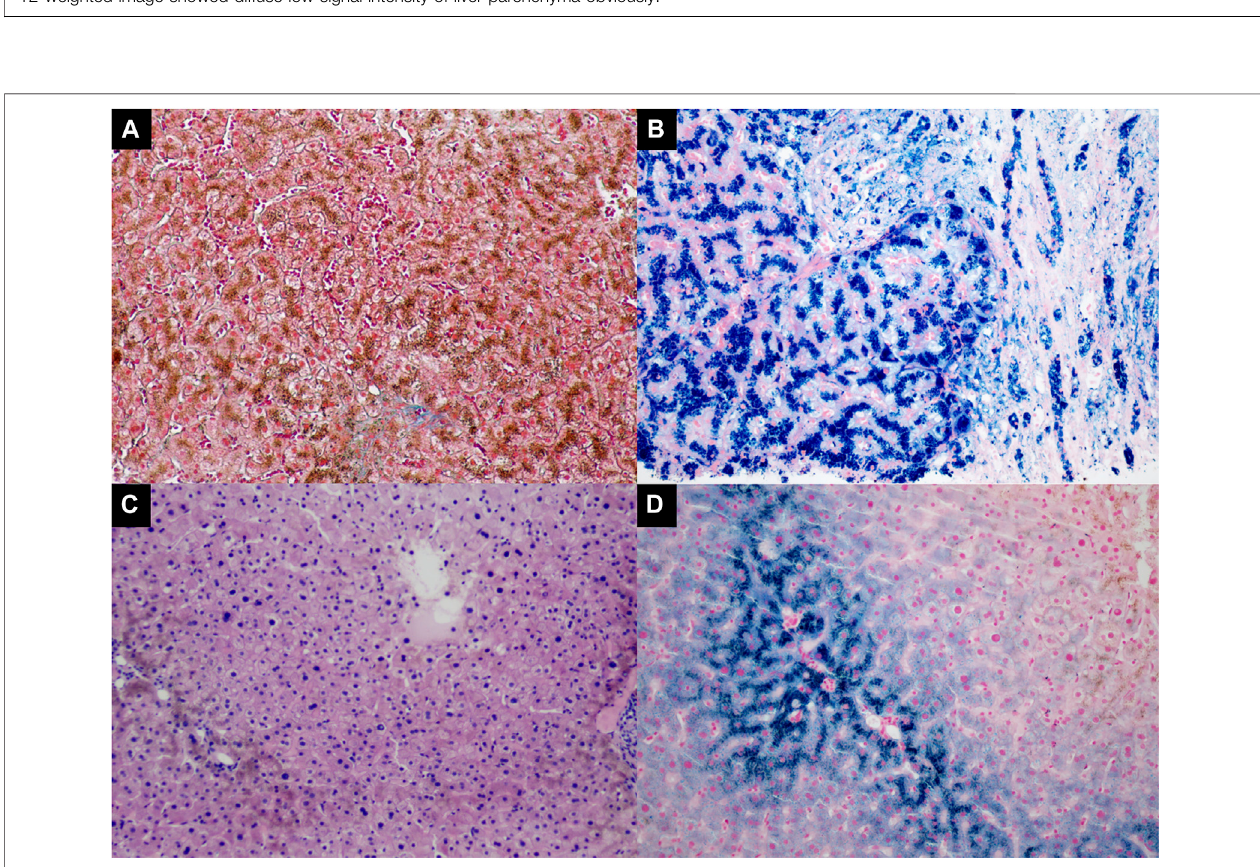
FIGURE 2 | The liver histopathology of the proband [Panel (A, B) , II-1] and the proband ’ s sister [Panel (C, D) , II-3]. (A) Increased collagen fi bers stained green by MassonTrichromestainintheexpanded fi brousportaltractwithcirrhosis(Massontrichrome,100×); (B) Markedirondepositioninthehepatocytesandbiliaryepithelium (Prussian blue, 200×); (C) Marked deposition of hemosiderin in the hepatocytes (H&E, 100×); (D) The proband ’ s sister had iron deposited in the periportal hepatocytes (Prussian blue, 200×).